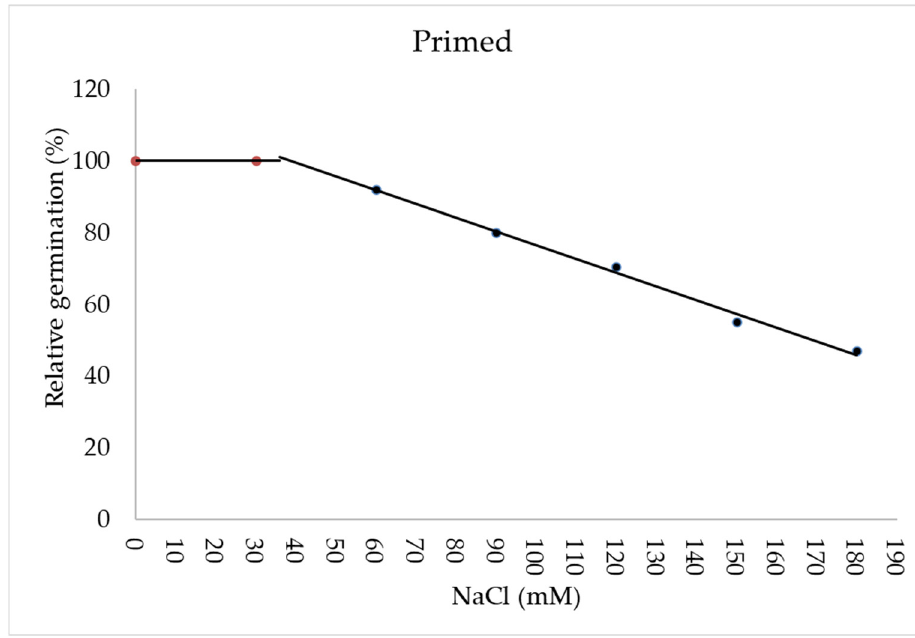
Figure 6. Hibiscus tea relative germination response to increasing salinity in primed seeds.